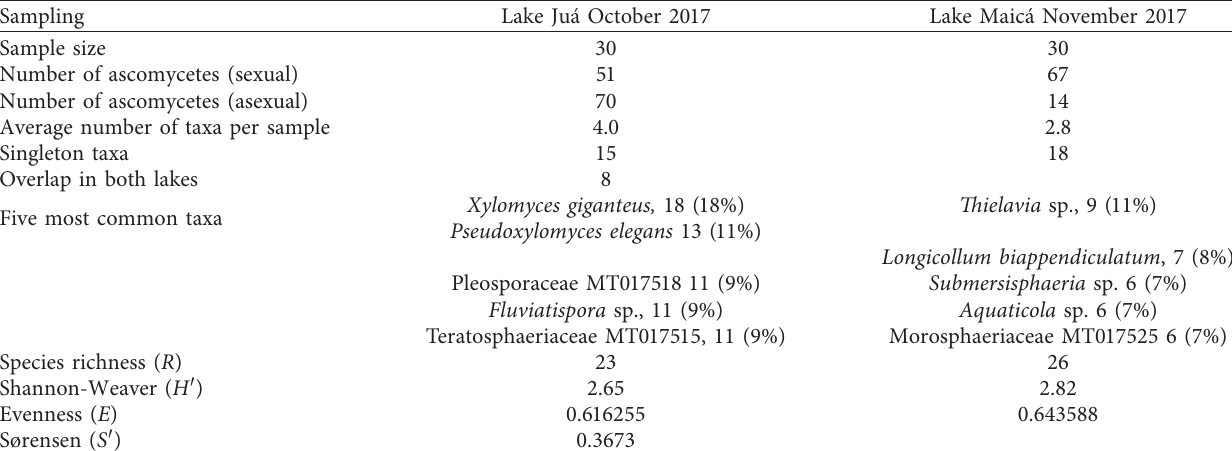
Table 4: Comparison of diversity (indices: H, E, and S of the fungi community present in the samples of the Lakes Ju´a and Maic´a, Santar´em, Par´a,